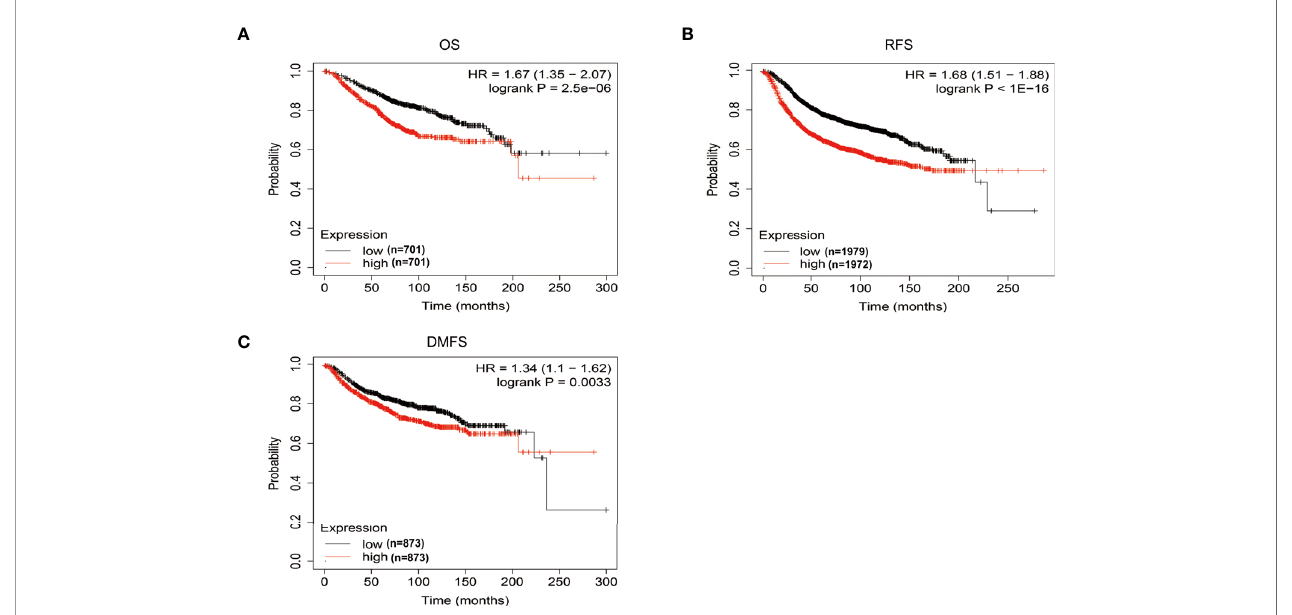
FIGURE 7 | The prognostic information of FEN1 via Kaplan-Meier Plotter database. (A – C) High FEN1 expression was correlated with poor prognosis regarding OS, RFS, and DMFS in BC patients.